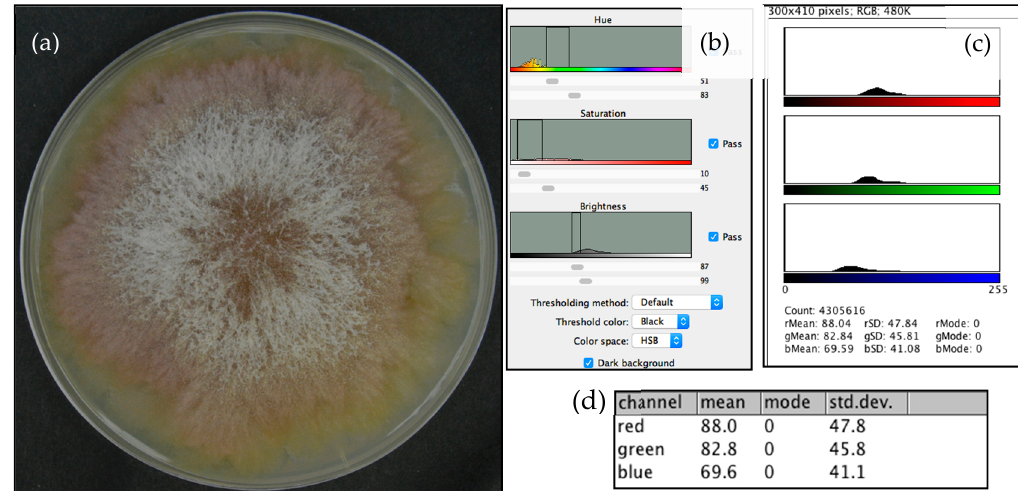
Figure 2 . Process of F. graminearum color analysis using ImageJ: ( a ) sample photo of the mold; ( b ) ImageJ panel used to remove the background by filtering colors; ( c ) color measurement panel; and ( d ) color measurement table.